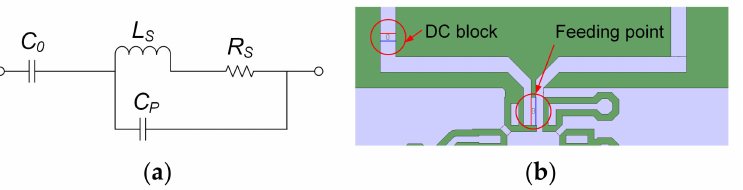
Figure A1. DC block: ( a ) Equivalent of real capacitor; ( b ) Fragment of an exemplary simulated RFID antenna with DC block.